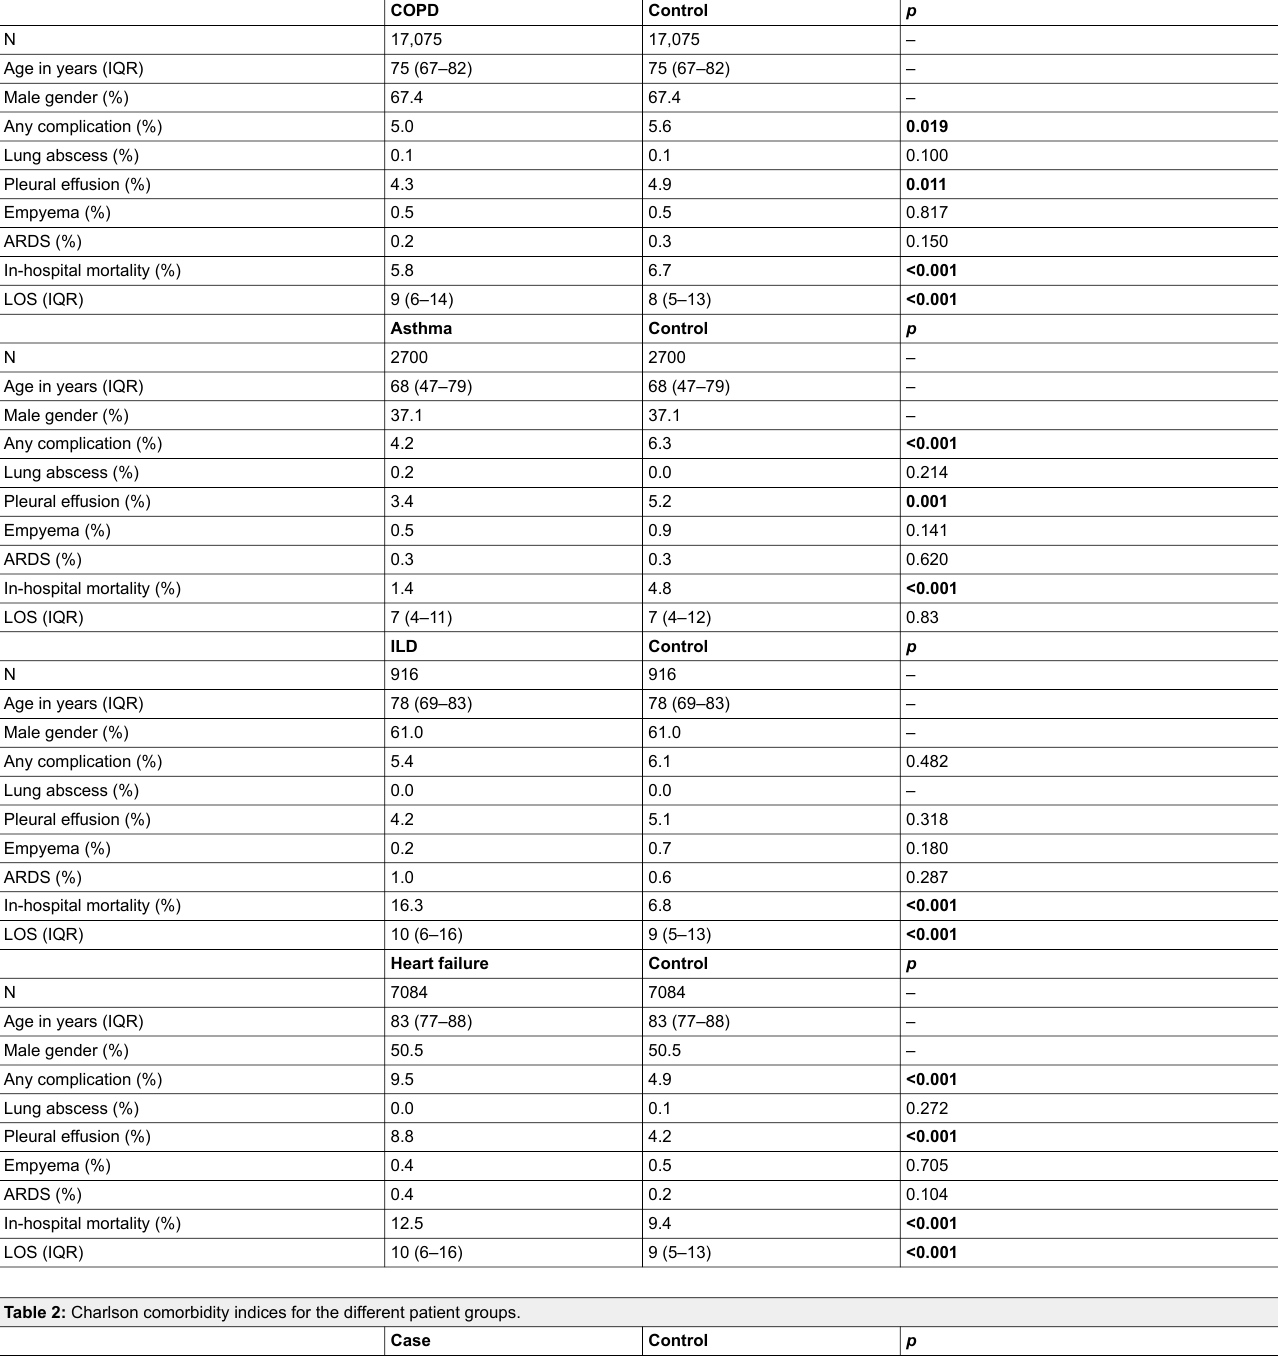
Table 1 : Outcome results of hospitalised CAP patients. Comparison of COPD, asthma, ILD and heart failure patients with their corresponding matched control groups. COPD Control p